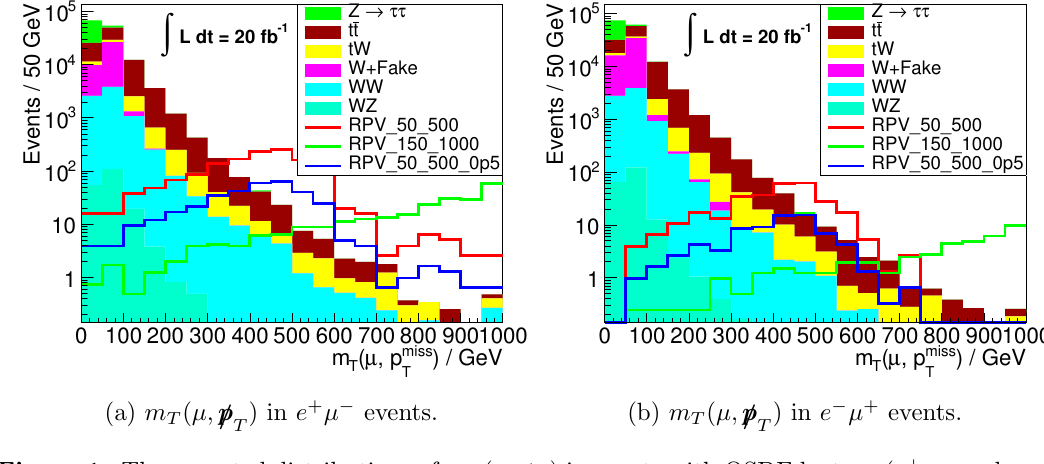
Figure 1. The expected distributions of m T ( (cid:22); =p in (a) and (b) respectively).